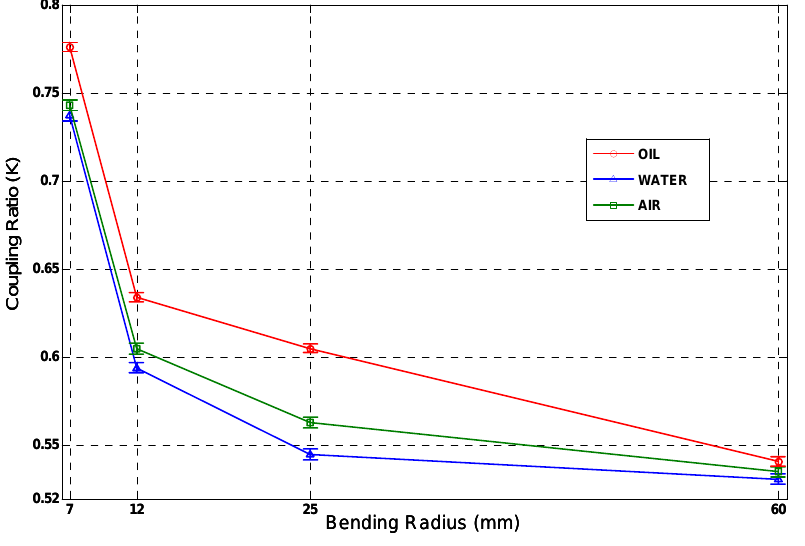
Figure 5. Measurements of the sensor coupling ratio versus bending radius, for different liquids. Errors in measurements, given as standard deviation, are also represented for each measurement